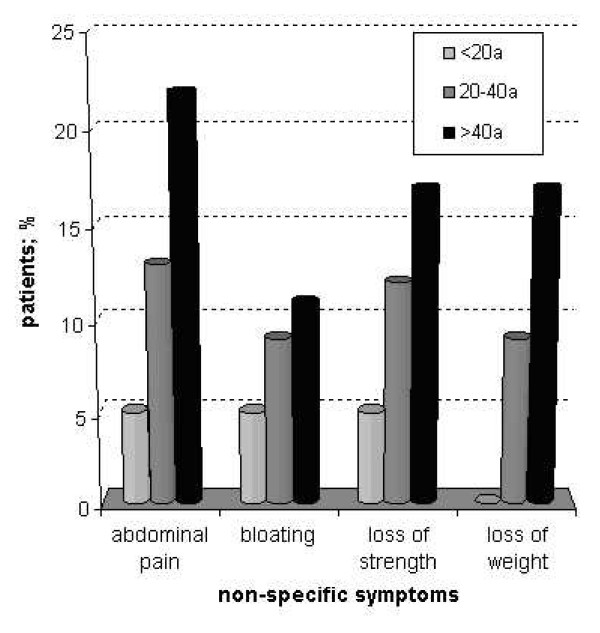
„Non-specific symptoms“ on primary diagnosis of FAP (n = 143 patients, realtive values regarding the corresponding subgroup of age)